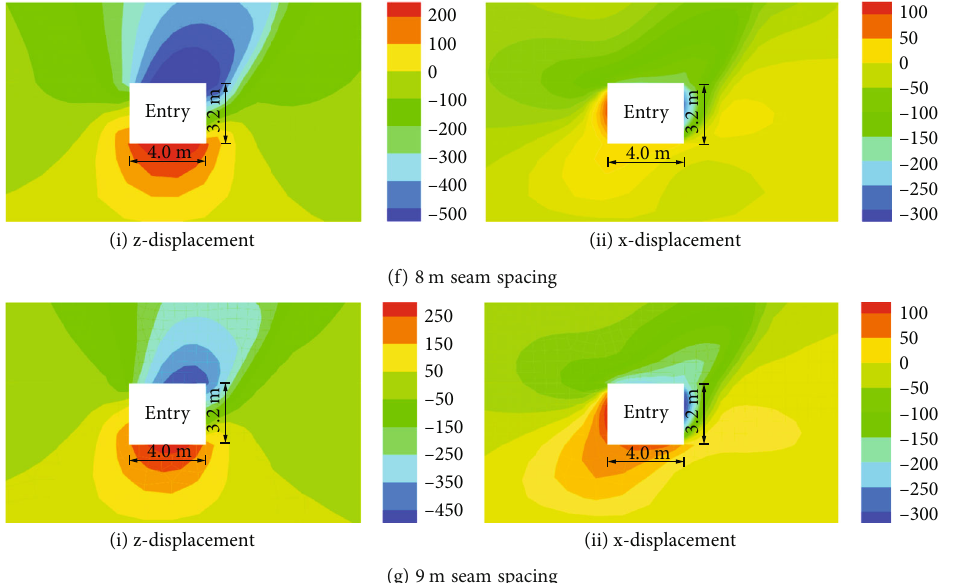
Figure 11: Displacement distribution around entry for di ff erent seam